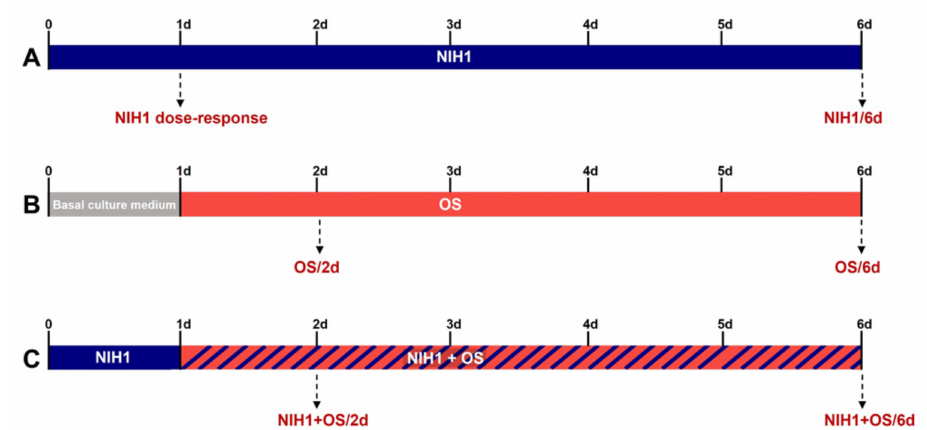
Figure 1. Graphical timeline describing the experimental design. The treatments are color coded: NIH1, blue; OS, orange; NIH1 + OS, blue-dashed orange, basal culture medium, gray. ( A ) NIH1 effects: Dose-response analysis performed after one day (1d) and long- term analysis performed after six days (NIH1/6d) of incubation. ( B ) OS model: Pre-treatment with basal culture medium for the first day and OS treatment for the subsequent one day (OS/2d) or five days (OS/6d) of incubation.